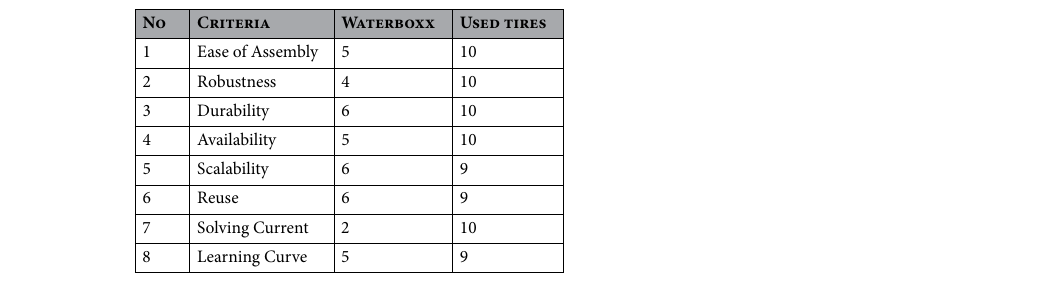
Table 2. Quality profile of original and proposed